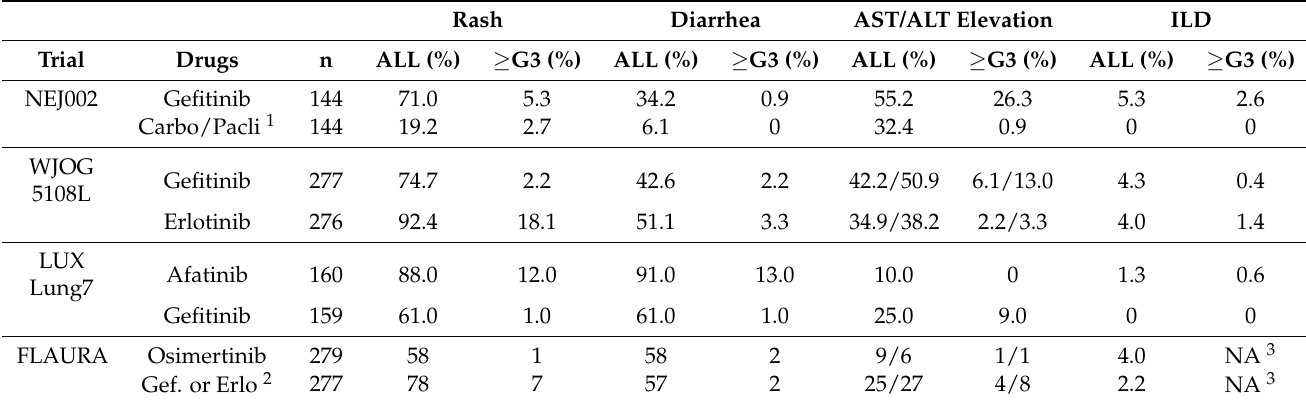
Table 1. Incidence of class-specific adverse events associated with epidermal growth factor receptor (EGFR)-tyrosine kinase inhibitors (TKIs) for treatment of non-small cell lung cancer (NSCLC). Rash Diarrhea AST/ALT Elevation ILD